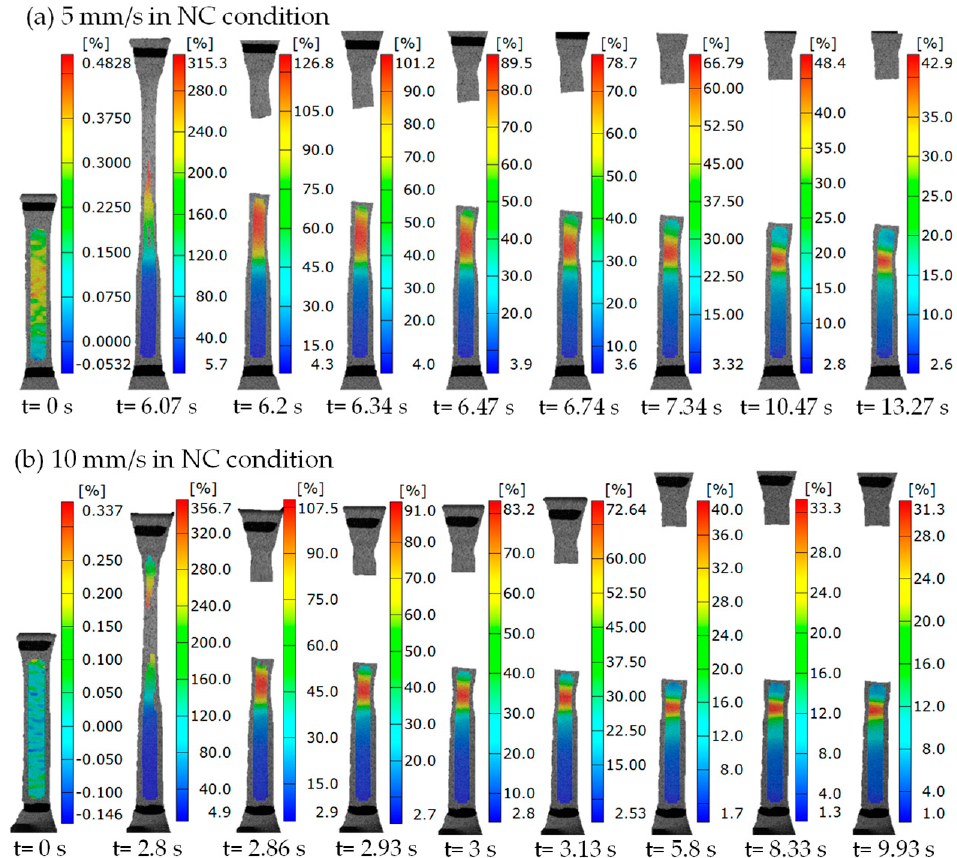
Figure 12. Pictures of strain contours from tension to fracture at different moments with the loading rates of ( a ) 5 mm/s and ( b ) 10 mm/s in the NC condition.